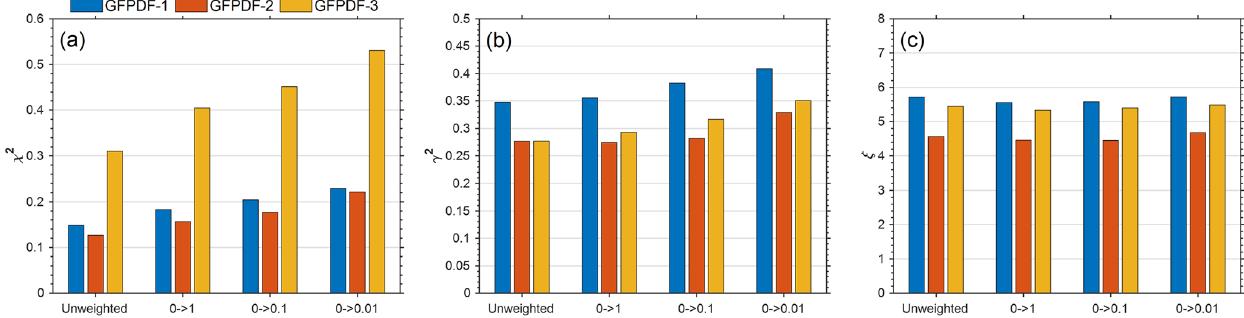
Figure 2. Comparison of reconstruction residual ( χ 2 ) (a) , the GF-PDF error ( γ 2 ) (b) , and the smoothness ( ξ ) (c) of GF-PDFs inverted using the unweighted and weighted LSQ methods with different weighting schemes for zero-value D ∗ p bins (i.e., replacing zero values by 1, 0.1, and 0.01, respectively). Colors correspond to the pre-defined GF-PDFs with one mode (blue), two modes (orange), and three modes (yellow). The results are averages based on inversions of 500 sets of synthetic HFIMS data for each of the three pre-defined GF-PDFs.